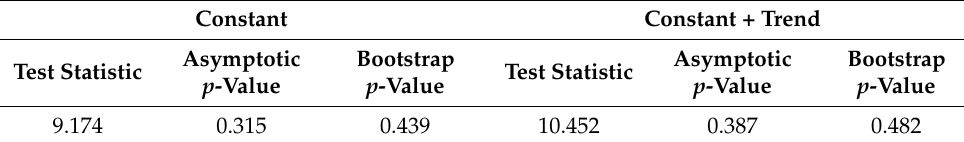
Table 7. Bootstrap cointegration test